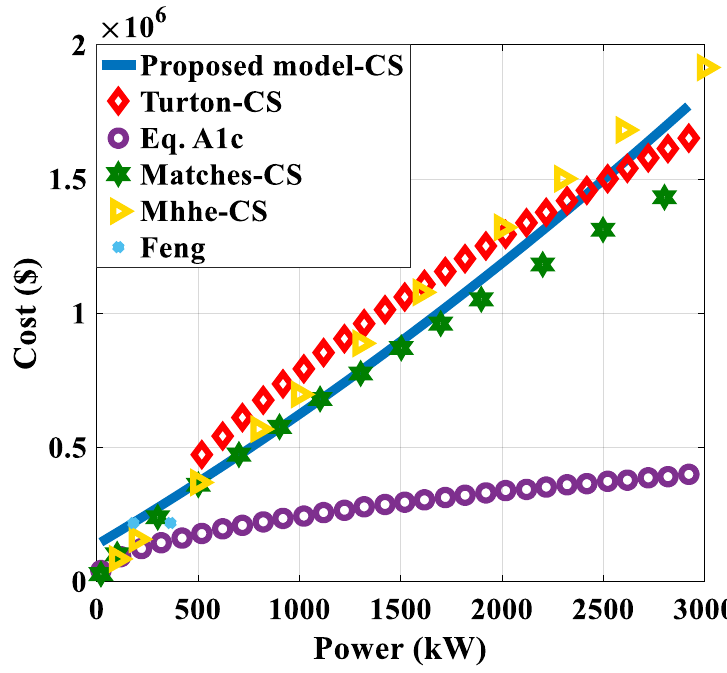
Figure 4. Compressor (centrifugal) cost against power [28,32,48,49,51].